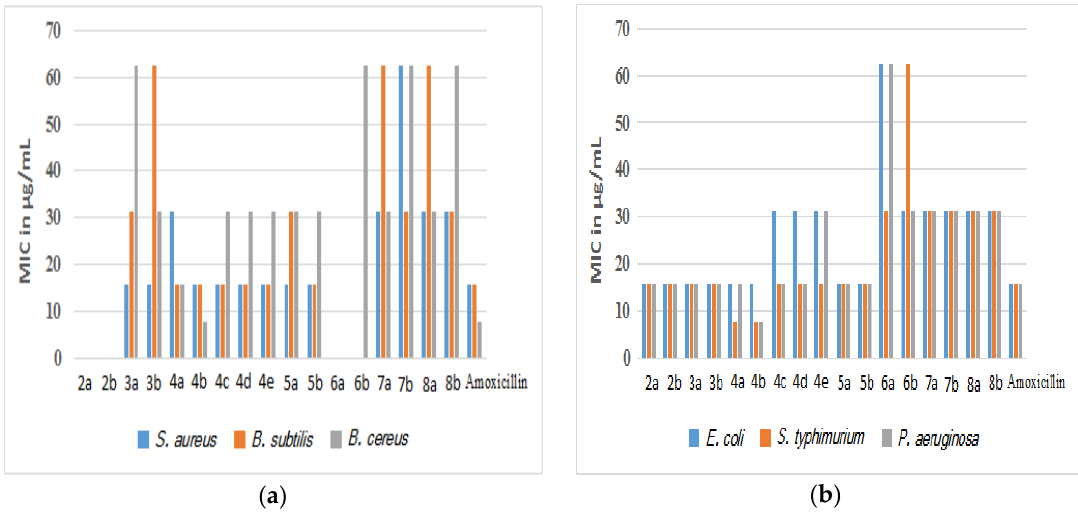
Figure 2. Antibacterial activity (MIC in µ g / mL) of the target compounds against ( a ) three strains of Gram-positive bacteria and ( b ) three strains of Gram-negative